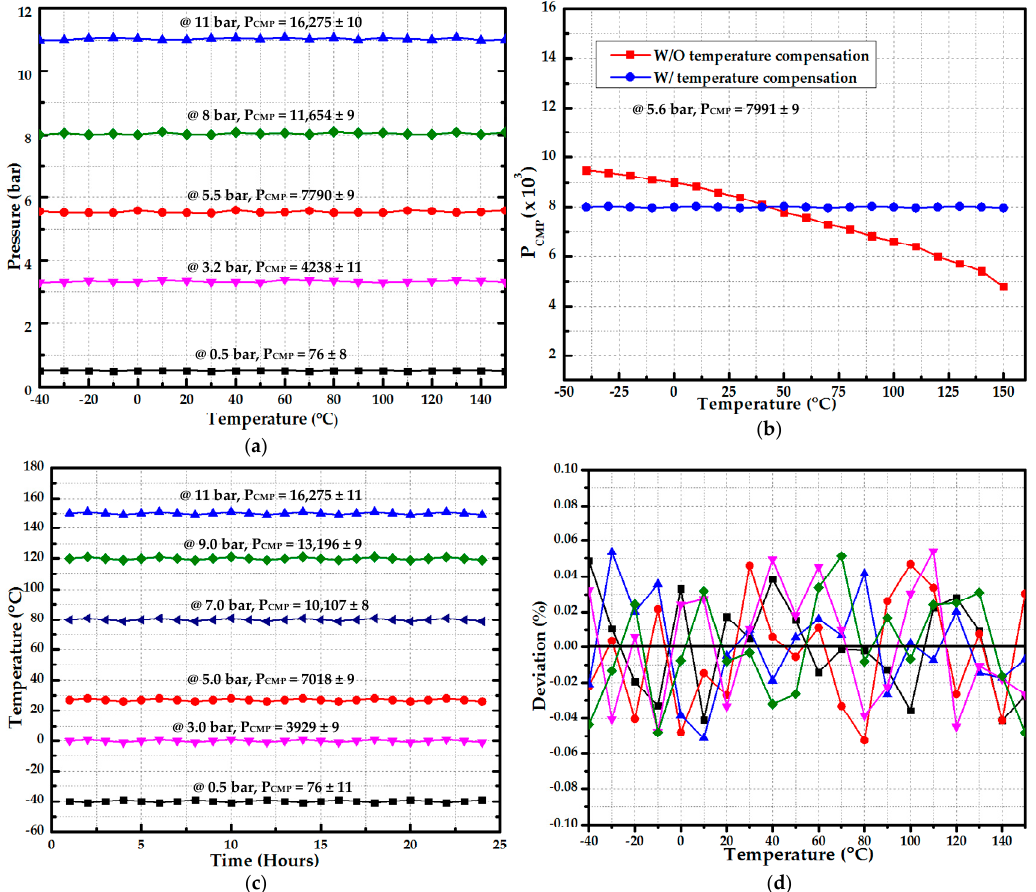
Figure 12. Temperature-compensation measurement results: ( a ) temperature compensation results at different input pressure; ( b ) with and without temperature compensation at 5.6 bar input pressure; ( c ) 24-h measurement at different fixed pressure and constant temperature; ( d ) percentage output deviation from ideal value at different pressures with full temperature range.